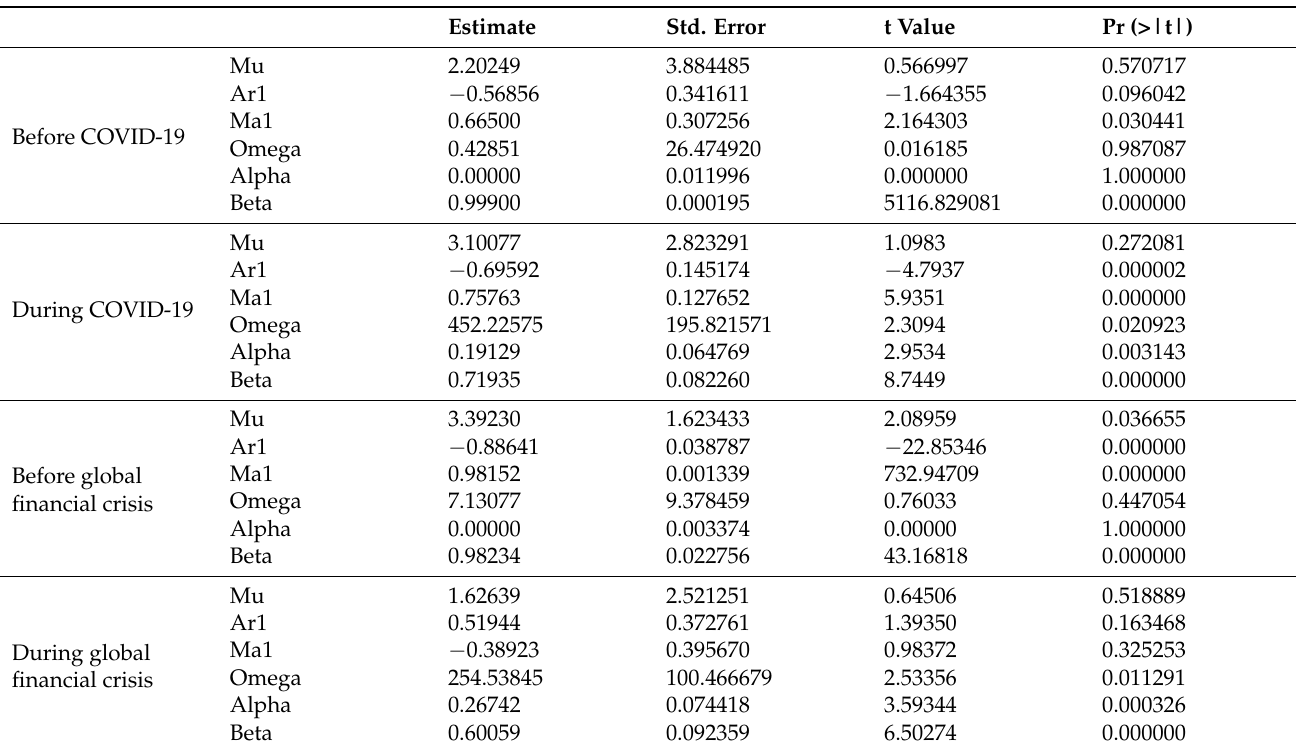
Table 8. GARCH (1,1) Parameters of